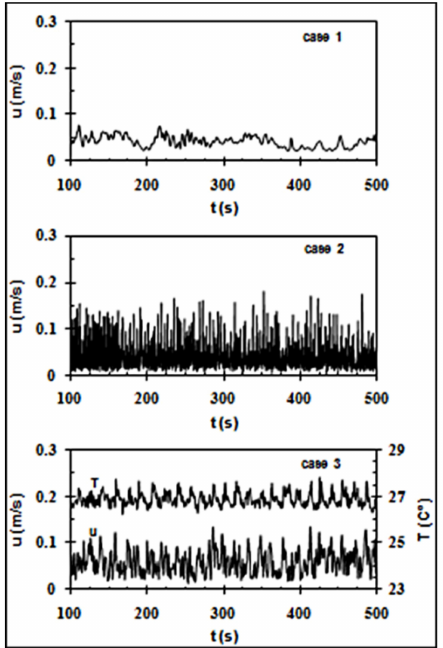
Figure 7. Time history of velocity magnitude (for cases 1–3) and temperature (for case 3 only) at Y = 0.5 height along the P 10